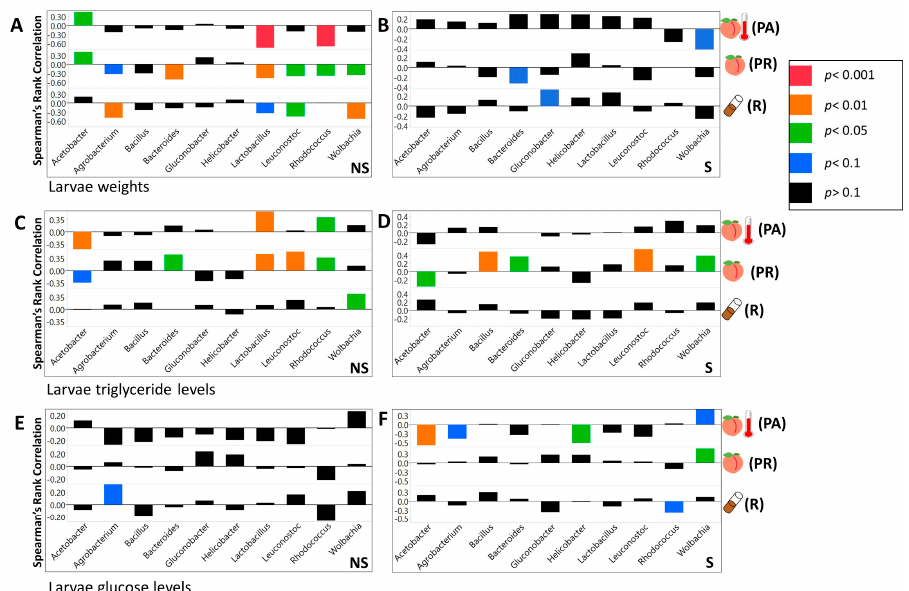
Figure 6. The correlations between the abundance of symbiotic bacterial taxa and larvae metabolic phenotypes vary with the diets. Spearman’s rank correlation coefficients between the abundance of 10 dominant bacterial genera and larvae phenotypes, on each diet. The color of the bars corresponds to the level of significance for each correlation (uncorrected for multiple comparisons). ( A ) Weight of NS larvae. ( B ) Weight of S larvae. ( C ) Triglyceride levels of NS larvae. ( D ) Triglyceride levels of S larvae. ( E ) Glucose levels of NS larvae. ( F ) Glucose levels of S larvae. The effect that symbiotic bacteria produce on all metabolic phenotypes may change with the diet.